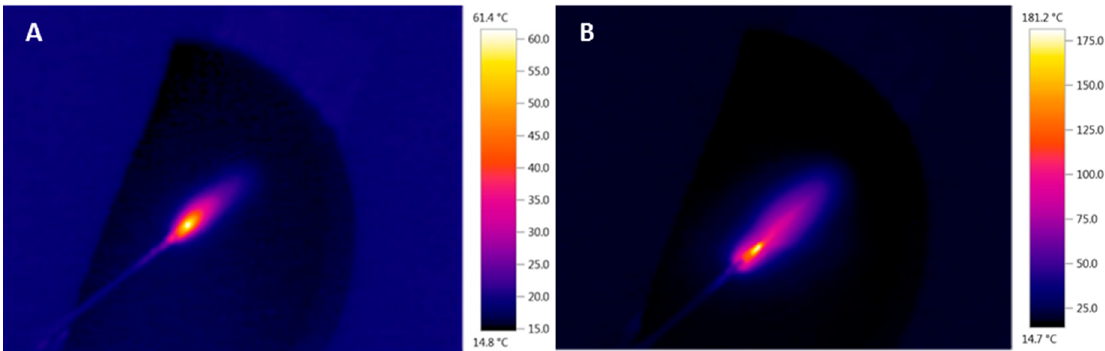
Figure 2. Cutting of chicken tissue with low-temperature electrosurgery unit ( A ) and low-frequency electrosurgery unit ( B ).